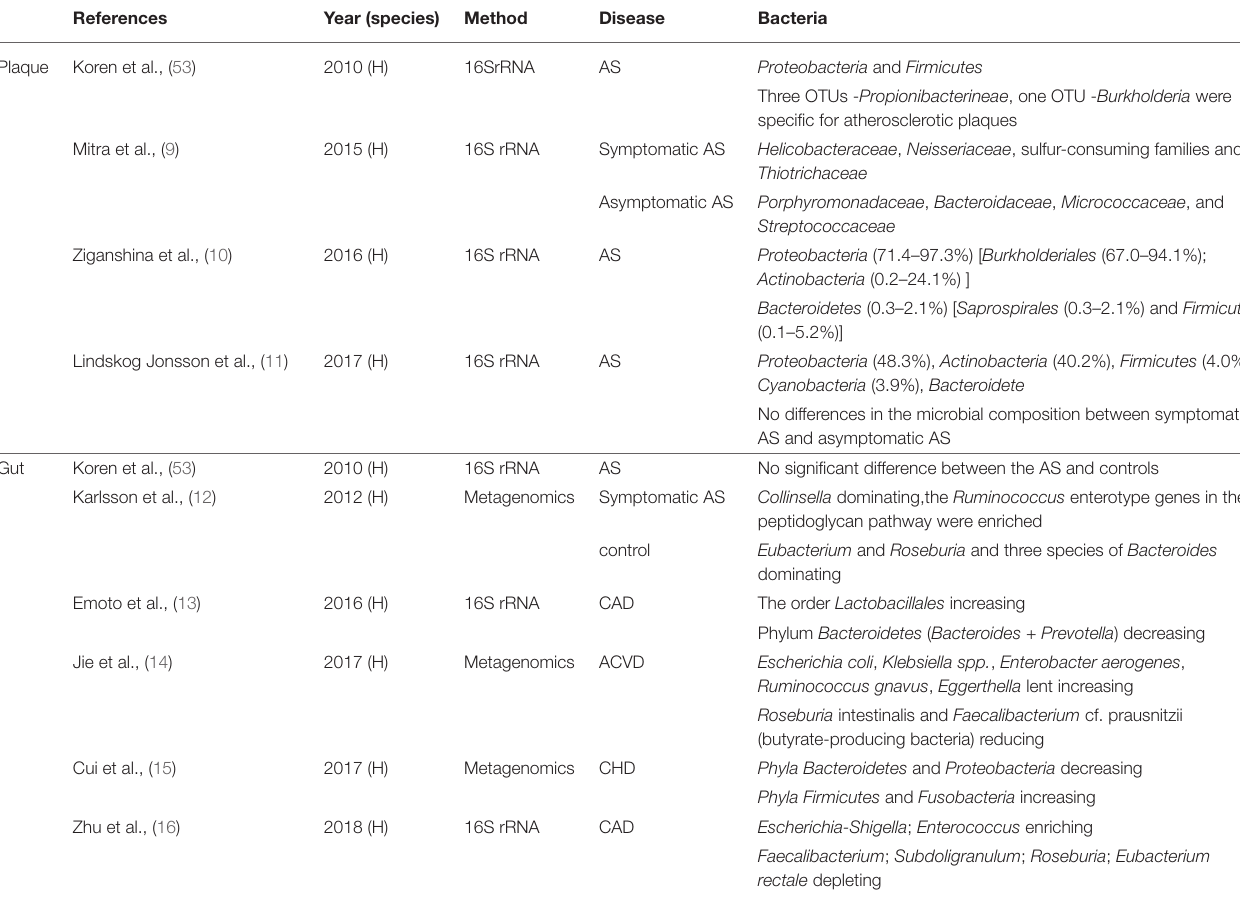
TABLE 1 | Different kinds of bacteria present in the plaque, and the gut bacterial changes between the controls and